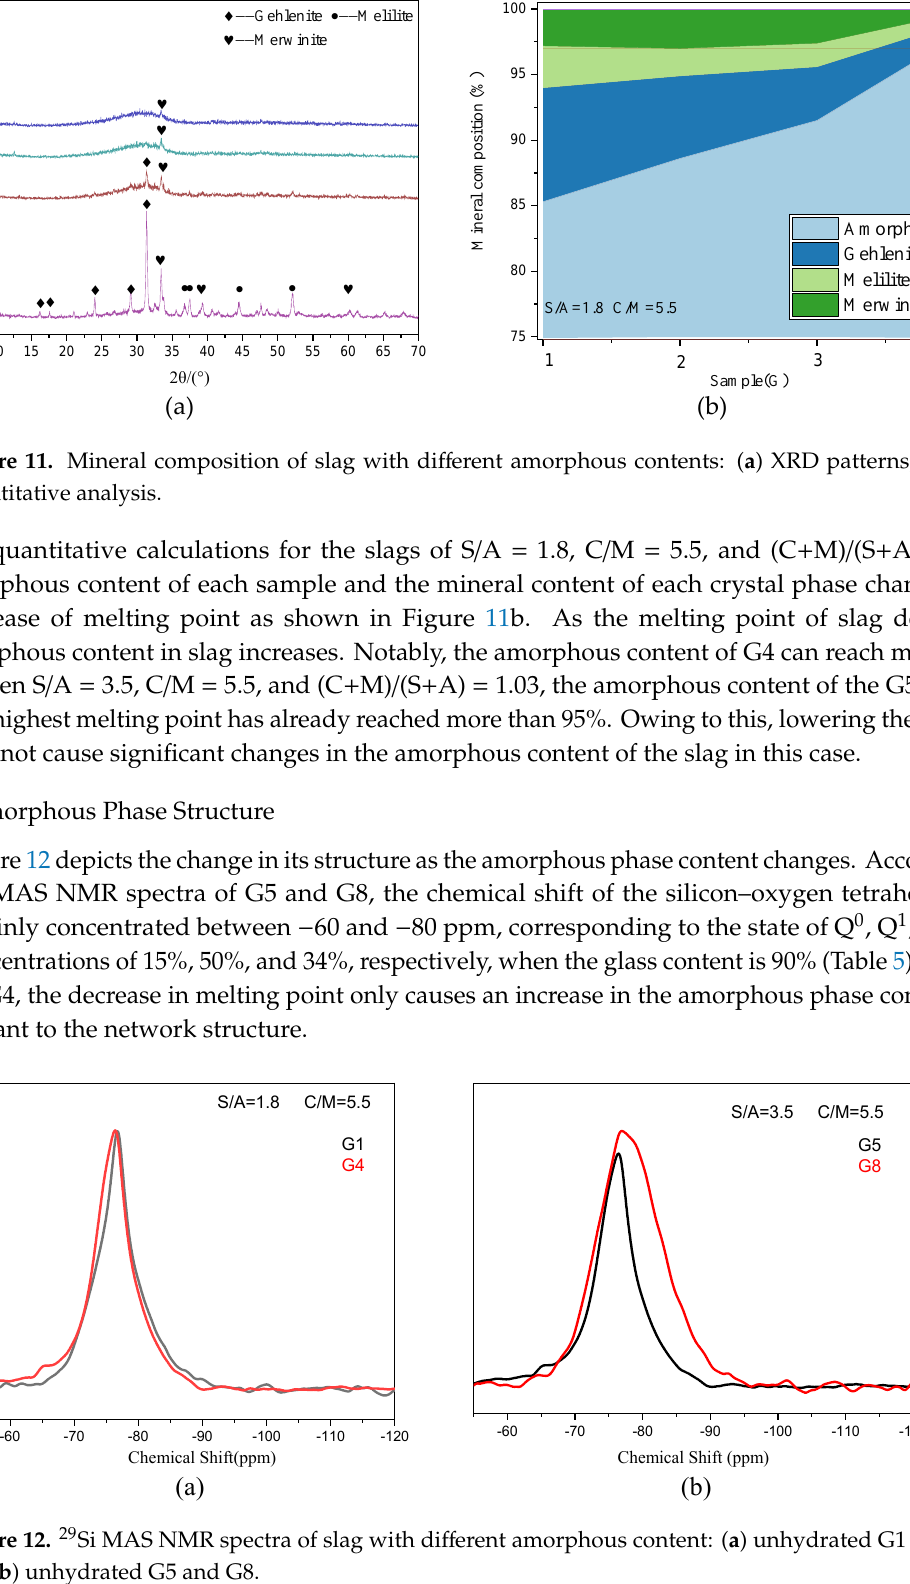
G4; ( b ) unhydrated G5 and G8. 401